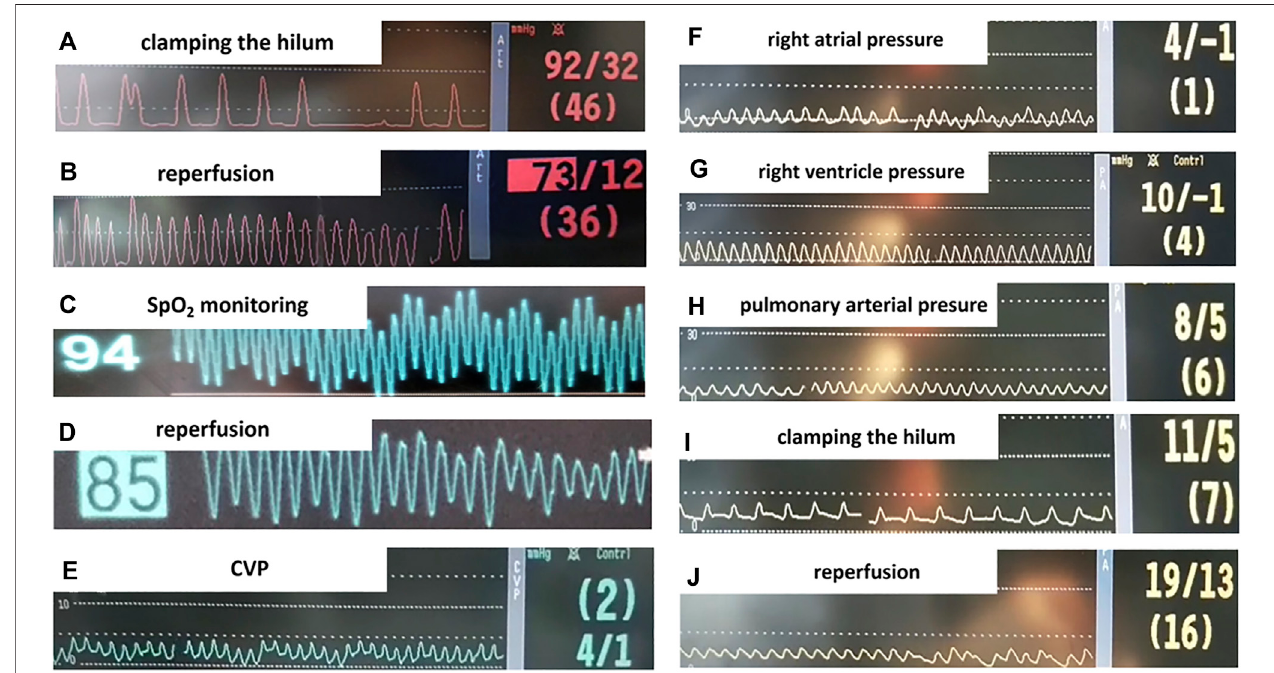
FIGURE 3 | Monitoring parameters during surgery. (A,B) Systemic blood pressure before and after we clamped the hilum. (C,D) SpO 2 before and after lung reperfusion. (E-J) Rightheartcatheterization(RHC)intheratlungIRmodelandintraoperativemonitoring. (E) Centralvenouspressure(CVP)measuredbyRHC. (F) Right atrial pressure. (G) Right ventricle pressure. (H ) Pulmonary arterial pressure (PAP). (I) PAP when left lung hilum clamped, the animal presented bradycardia with PAP slightly elevated. (J) Elevated PAP during lung